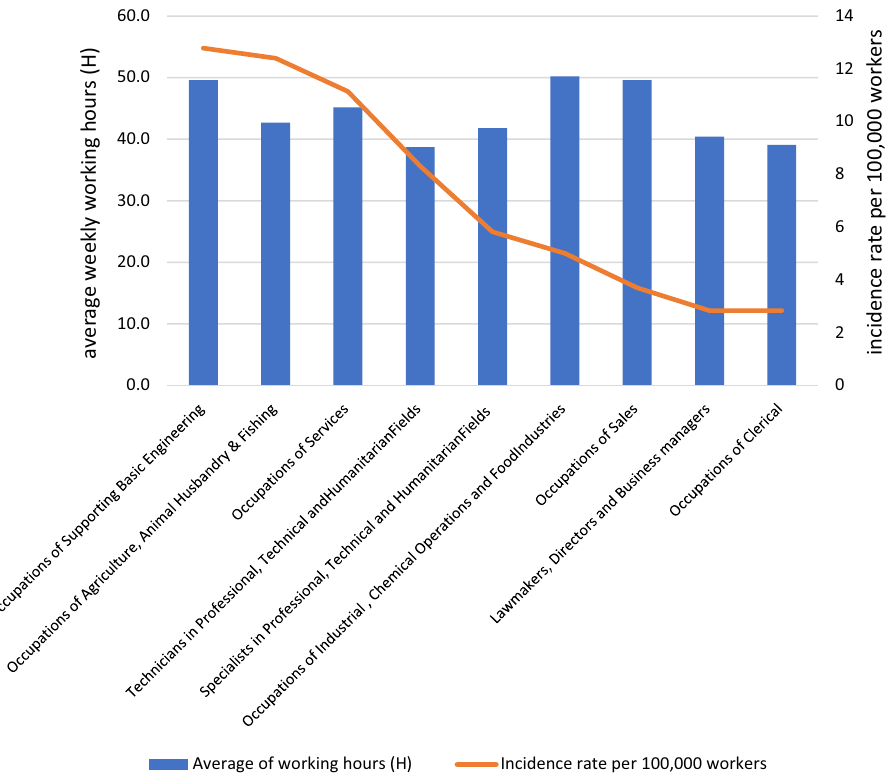
Figure 4. Average weekly working hours and TB incidence rate among main occupational group in Makkah region